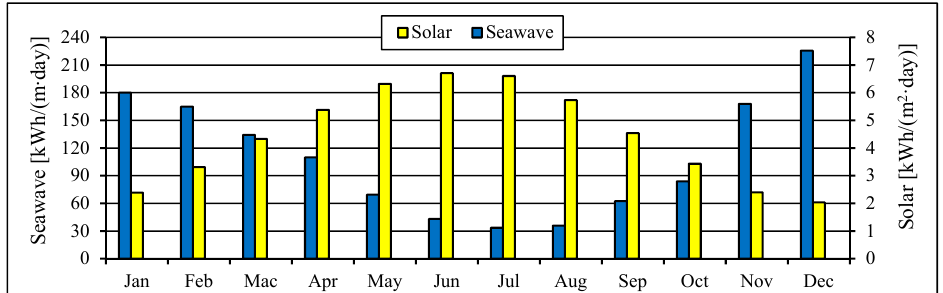
Figure 9. Comparison between solar and sea-wave trends.